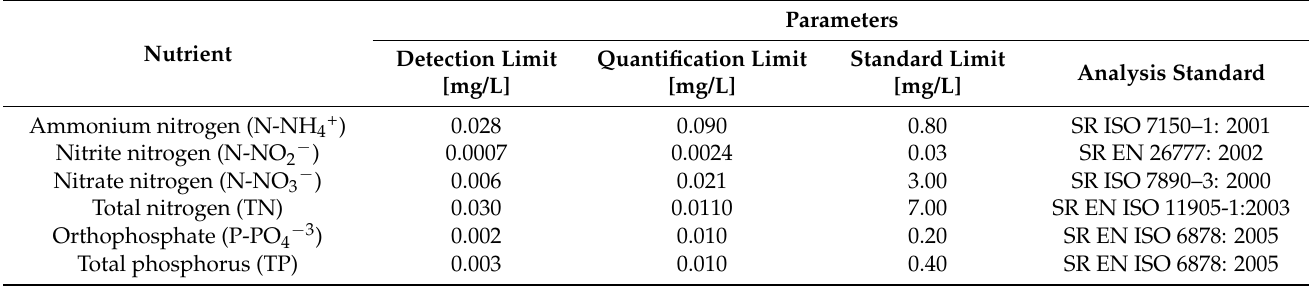
Table 2. Detection and quantification limits for